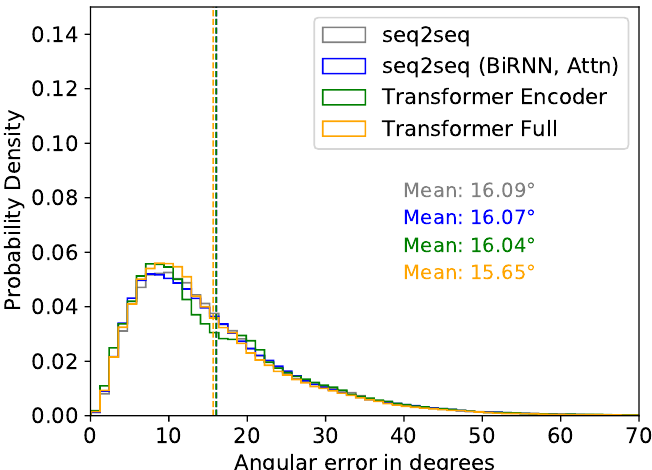
Figure 18. Distribution of the mean angular error for motion inference using the sparse segments of XSens MVN (from the new